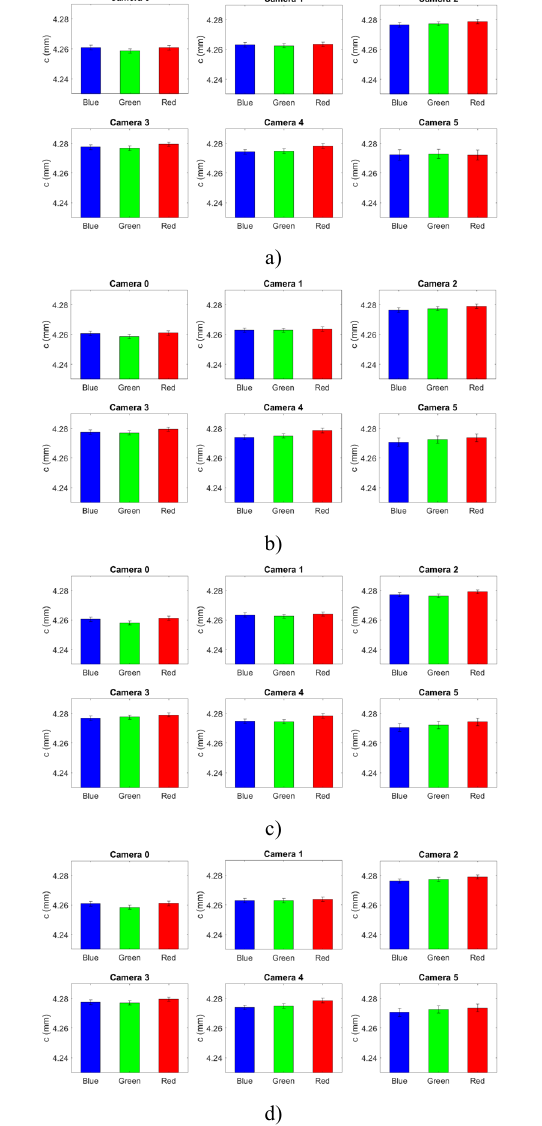
Figure 4. Ladybug5 principal distances and 95% confidence intervals. a) Case 1, b) Case 2, c) Case 3, d) Case